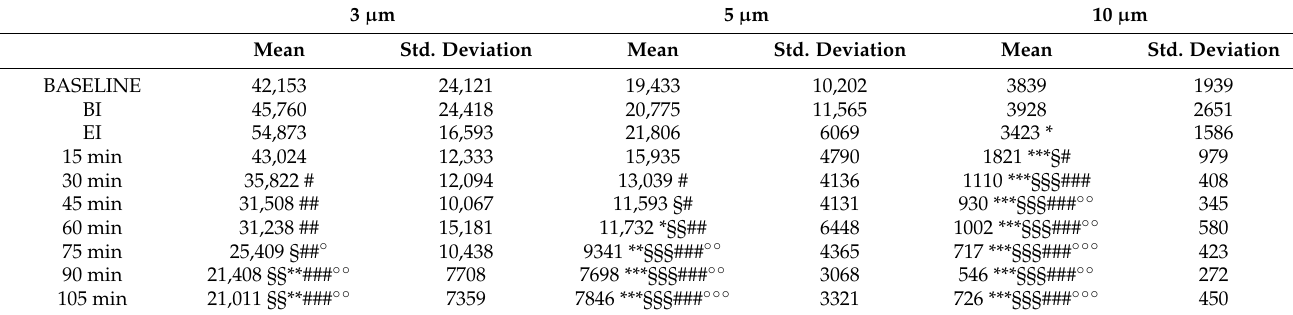
Table 2. Means and standard deviations of particles of extremely and ultra-fine aerosols throughout the study. Table legend. * p < 0.05 vs. baseline; ** p < 0.01 vs. baseline; *** p < 0.001 vs. baseline; § p < 0.05 vs. BI; §§ p < 0.01 vs. BI; §§§ p < 0.001 vs. BI; # p < 0.05 vs. EI min; ## p < 0.01 vs. EI min; ### p < 0.01 vs. EI min; ◦ p < 0.05 vs. 15 min; ◦◦ p < 0.01 vs. 15 min; ◦◦◦ p < 0.001 vs. 15